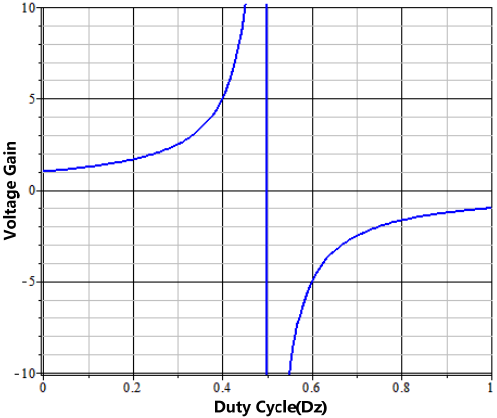
Figure 8. Voltage gain of the q ‐ Zsource.